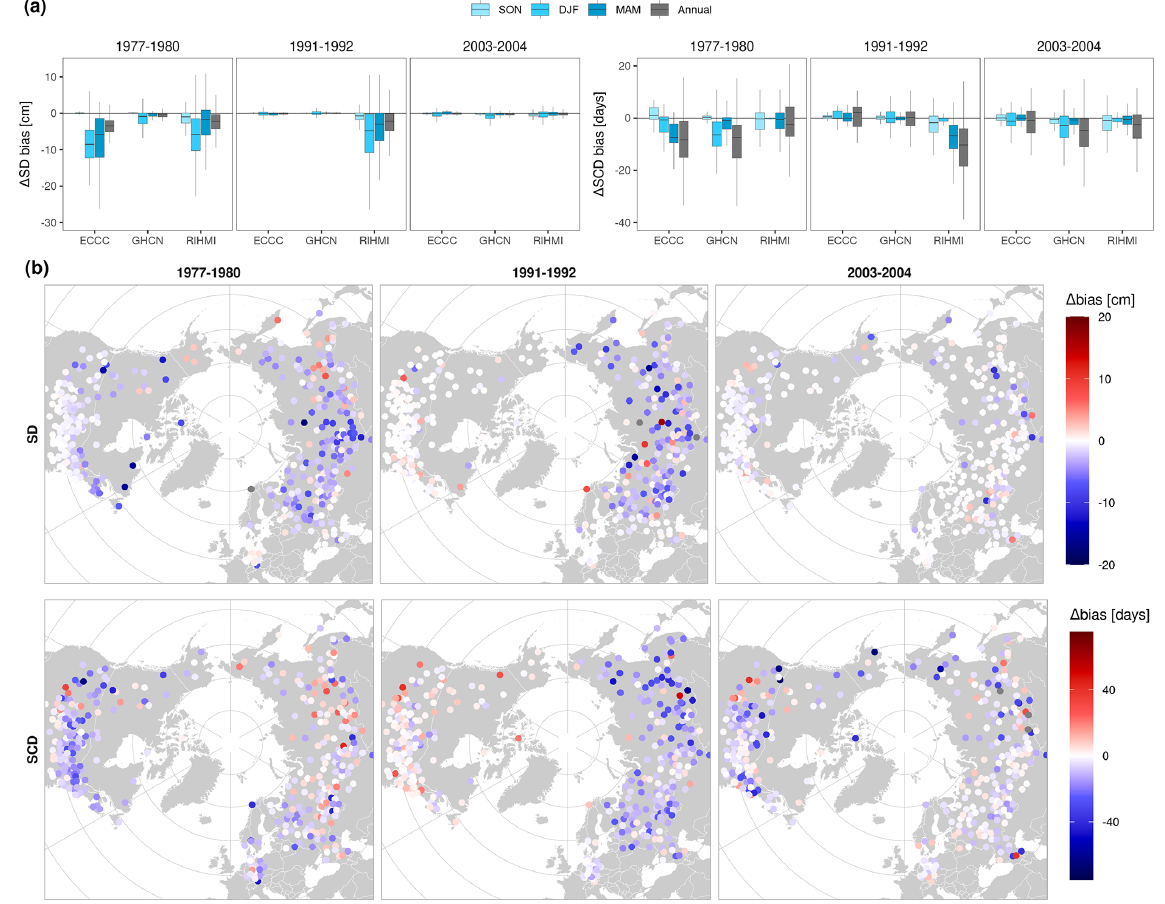
Figure 7. Change in the ERA5 bias in snow depth (SD) and snow cover duration (SCD) during 1977–1980, 1991–1992, and 2003–2004 discontinuities. The 4 years before and after the discontinuity are compared ( (cid:49) bias = bias after − bias before ). (a) Seasonal change in the bias per network. (b) Annual change in the bias per